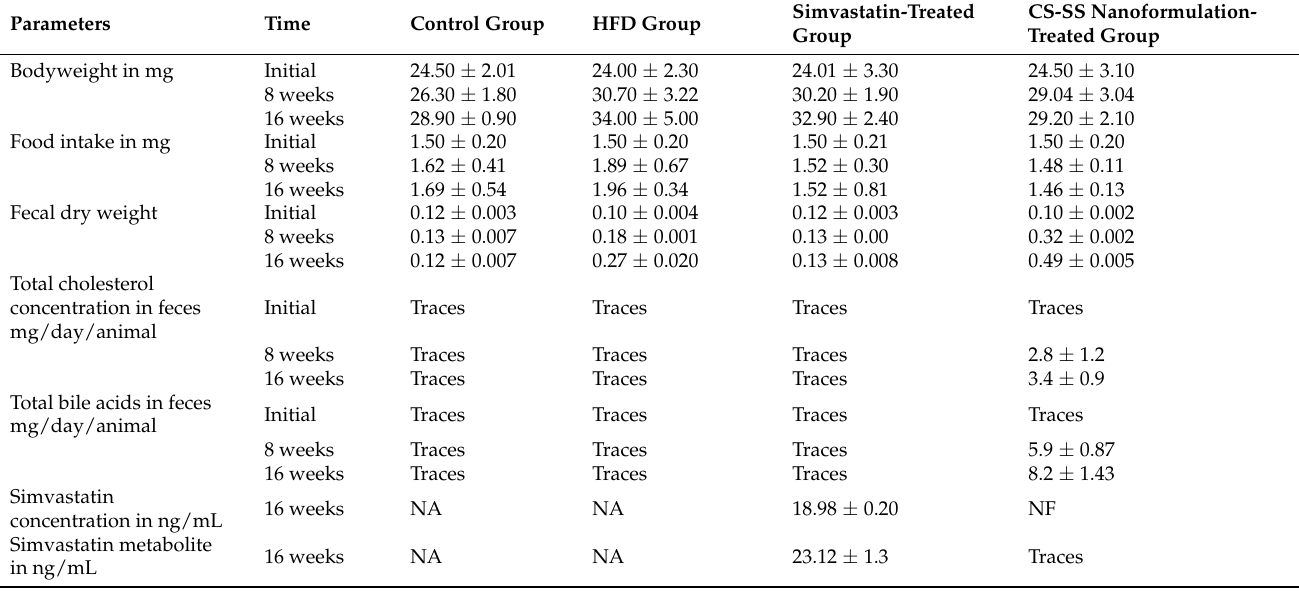
Table 3. Results depicting the excretion parameters of CS-SS